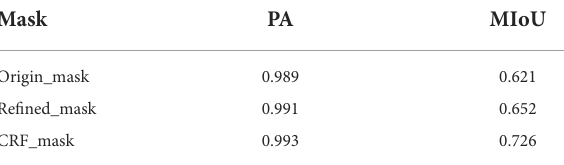
TABLE 2 Numerical comparison results of different masks.